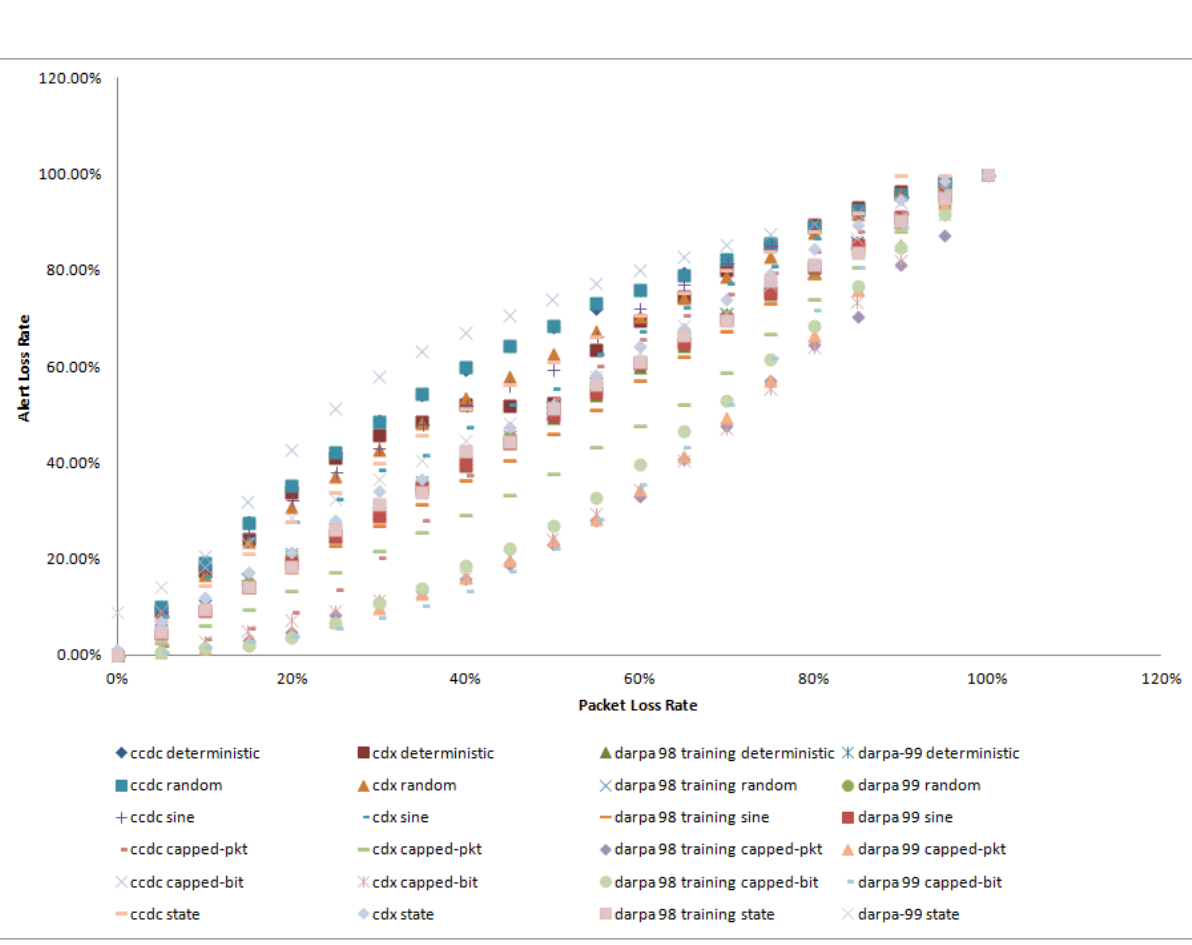
Fig. 5 Alert Loss Rate vs. Packet Loss